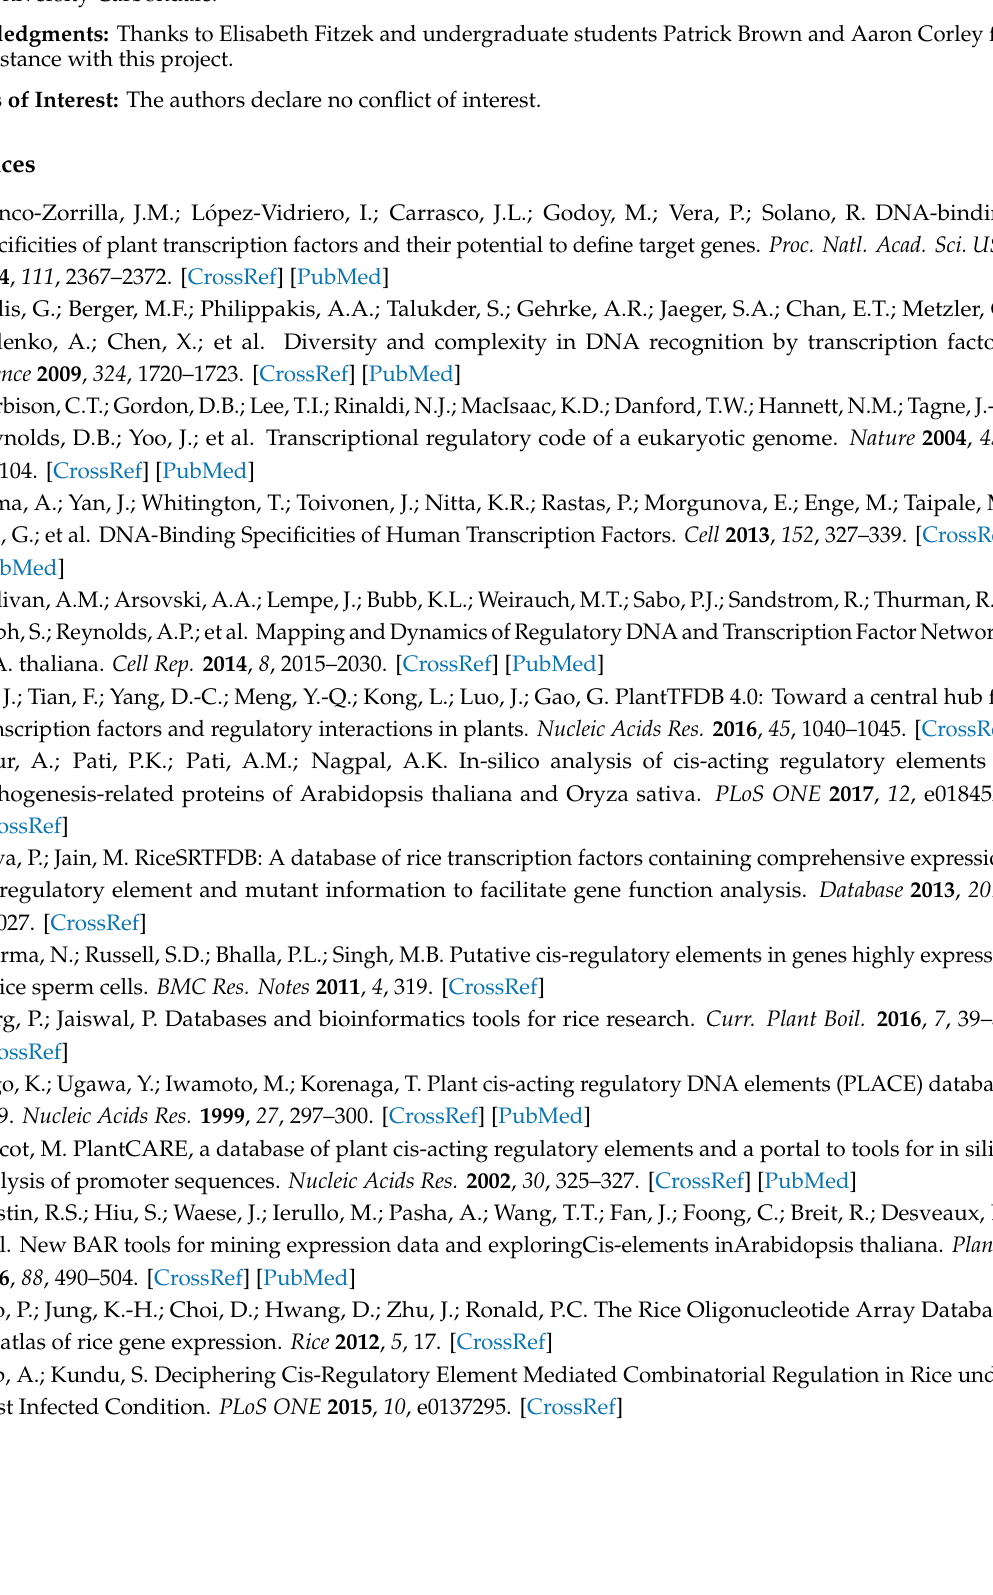
Supplementary Table S1. Rice gene expression series (GSE) used for the identification of co-expressed genes and statistical correlation of CREs. Supplementary Table S2. TFs significantly associated to CREs ( p <